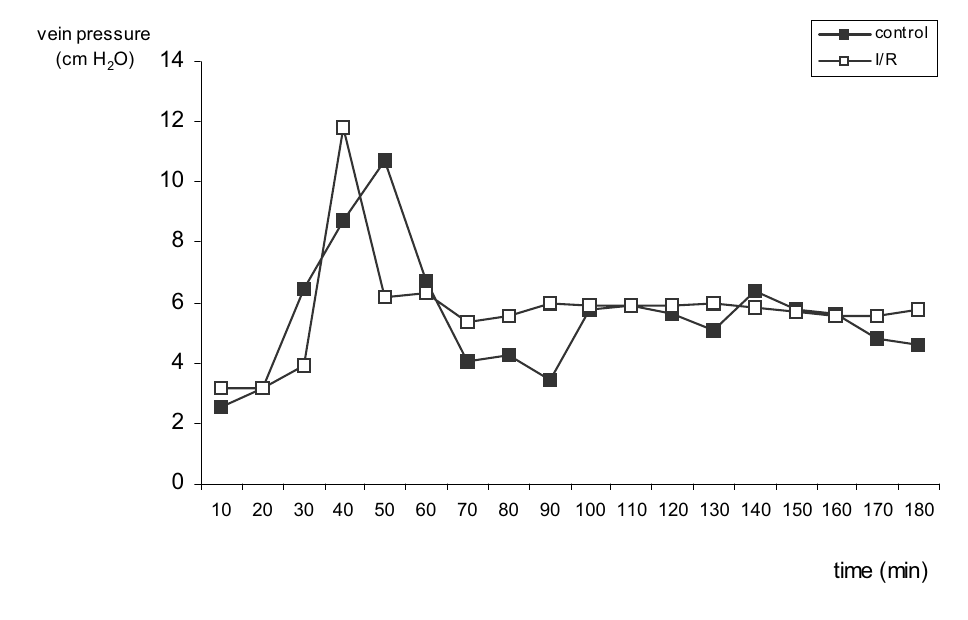
FIGURE 2 – Median vein pressure (cmH2O) along time (p < 0.05)